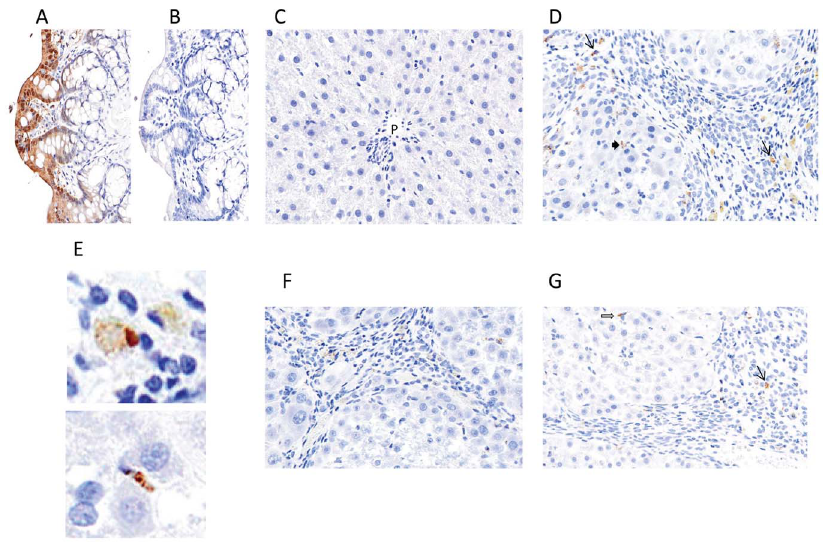
Figure 8. Galectin-3 Immunohistochemsitry. A: Rat colon B. Rat colon with omission of primary galectin-3 antibody; C: Normal rat liver; D: Rat liver treated with TAA as in figure 4 and treated with vehicle (Group 1); E: upper panel shows high power of stained portal macrophages; lower panel shows stained lobular sinusoidal cell with morphology of a stellate cell. F: Rat liver treated with TAA as in figure 4 and treated with GR-MD-02 (Group 4); G: Rat liver treated with TAA as in figure 4 and treated with GM-CT-01 (Group 7). doi:10.1371/journal.pone.0075361.g008 PLOS ONE |